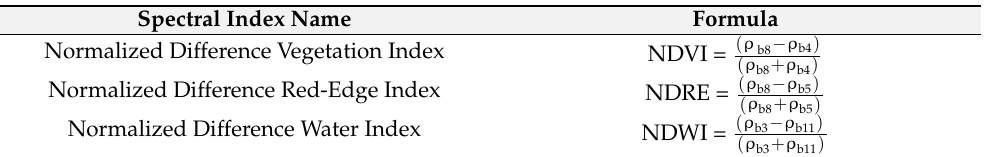
Table 3. Spectral indices used for this work. ρ atmosphere (BOA) reflectance values for S2 bands 3, 4, 5, 8, 11 and 12, respectively.